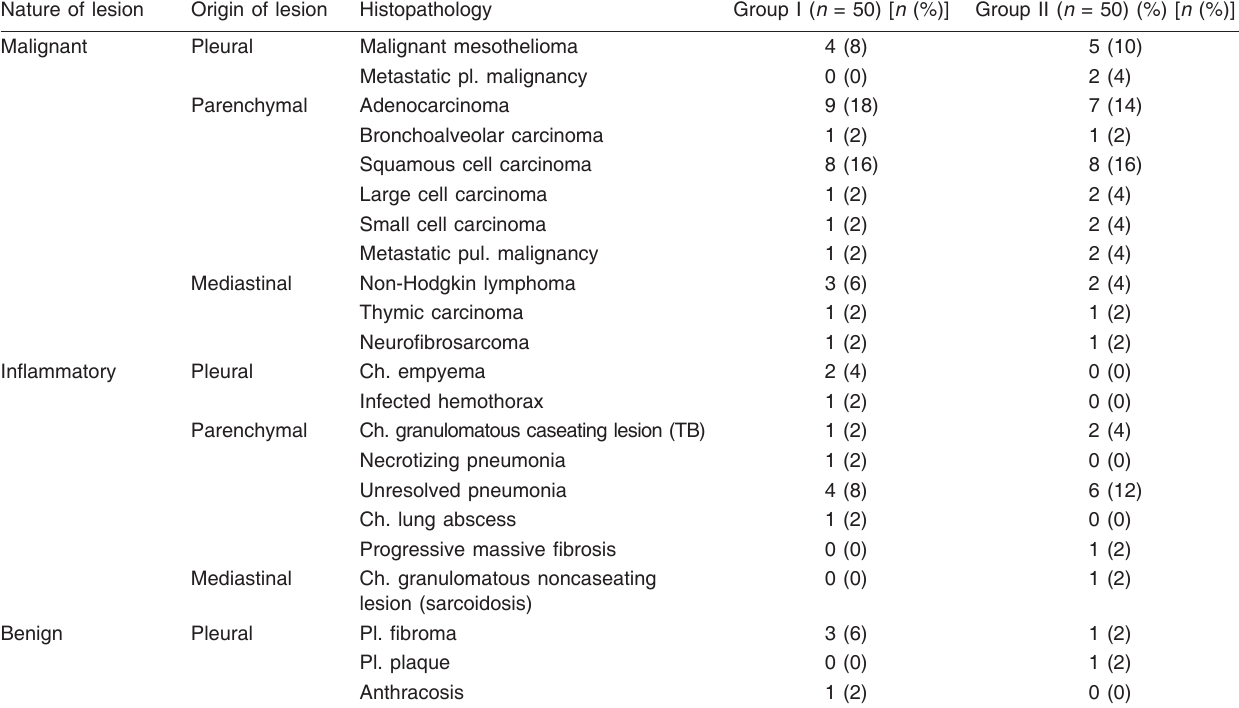
Table 3 The diagnostic outcome of ultrasound-guided biopsy versus computed tomography-guided biopsy in pleural, parenchymal, and mediastinal lesions Nature of